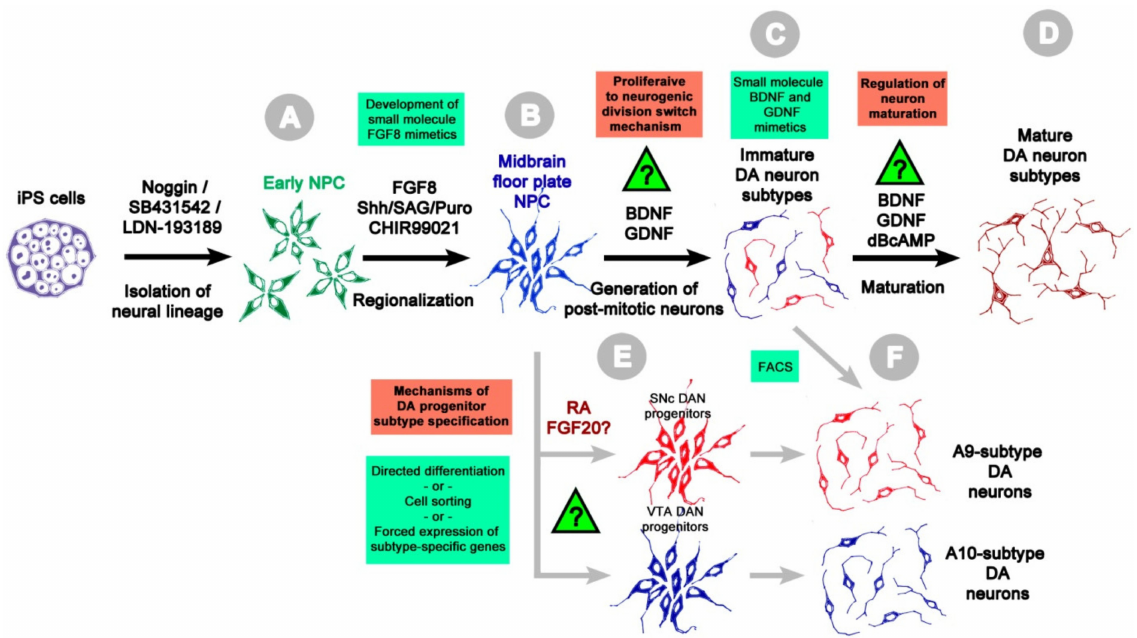
Figure 1. The general differentiation sequence of human iPS cells into the midbrain DA neurons. The crucial stages of in vitro differentiation protocols are shown by black arrows with small molecules and growth factors for inducing the neural lineage progression listed above. Grey arrows show potential routes for generation of pure or enriched cultures of specific midbrain DA neuron subtypes. Question signs indicate processes proceeding in vitro in uncontrolled/autonomous manner through unknown mechanisms highlighted in the red boxes; understanding of these mechanisms is critical for overcoming heterogeneity and asynchronicity of neuronal differentiation of iPS cells. The suggestions for optimizing or refining the differentiation conditions are shown in the green boxes. Withdrawal of iPS cells from self-renewing conditions and their treatment with TGF β antagonists either in monolayer culture or in suspension EBs induces the differentiation of early multipotent NPC ( A ). After isolation and expansion, these cells are regionalized into the midbrain floor plate NPC ( B ) through activation of Hedgehog, Wnt and FGF8 signaling. While several commercially available small molecules can efficiently substitute recombinant Shh and Wnt1/Wnt5a, no FGF8 mimetics have been developed to date. Alternatively, midbrain floor plate NPC can be directly obtained from iPS cells by the overexpression of Lmx1a , Foxa2 and Nurr1 , and other midbrain-specific TF genes. ( C ) Generation and ( D ) functional maturation of post-mitotic DA neurons are performed by their continuous maintenance in presence of neurotrophic factors BDNF and GDNF, and optionally dibutyril cAMP (dBcAMP) and Notch antagonists (e.g., DAPT) to promote their survival and differentiation. However, due to the lack of control over these processes the resulting cell populations are heterogenous, consisting of neural progenitors and different DA neuron subtypes at various stages of maturation. The development of small molecule mimetics of FGF8, BDNF and GDNF proteins would be beneficial for reducing the costs of generation of iPS cell-derived neurons. The generation of floor plate progenitor subtypes ( E ) can be potentially carried out by employing selective growth factor-based conditions, forced expression of subtype-specific TFs or isolation from mixed cultures by FACS. These progenitor subtypes could be further differentiated into corresponding subtypes of post-mitotic DA neurons ( F ). Alternatively, pure or enriched cultures of A9 and other midbrain DA neuron subtypes could be obtained by their isolation from mixed DA neuron cultures using FACS at the terminal differentiation stage. The detailed description of each stage is provided in the text. BDNF—brain derived neurotrophic factor, GDNF—glial cell derived neurotrophic factor, FGF8—fibroblast growth factor 8,